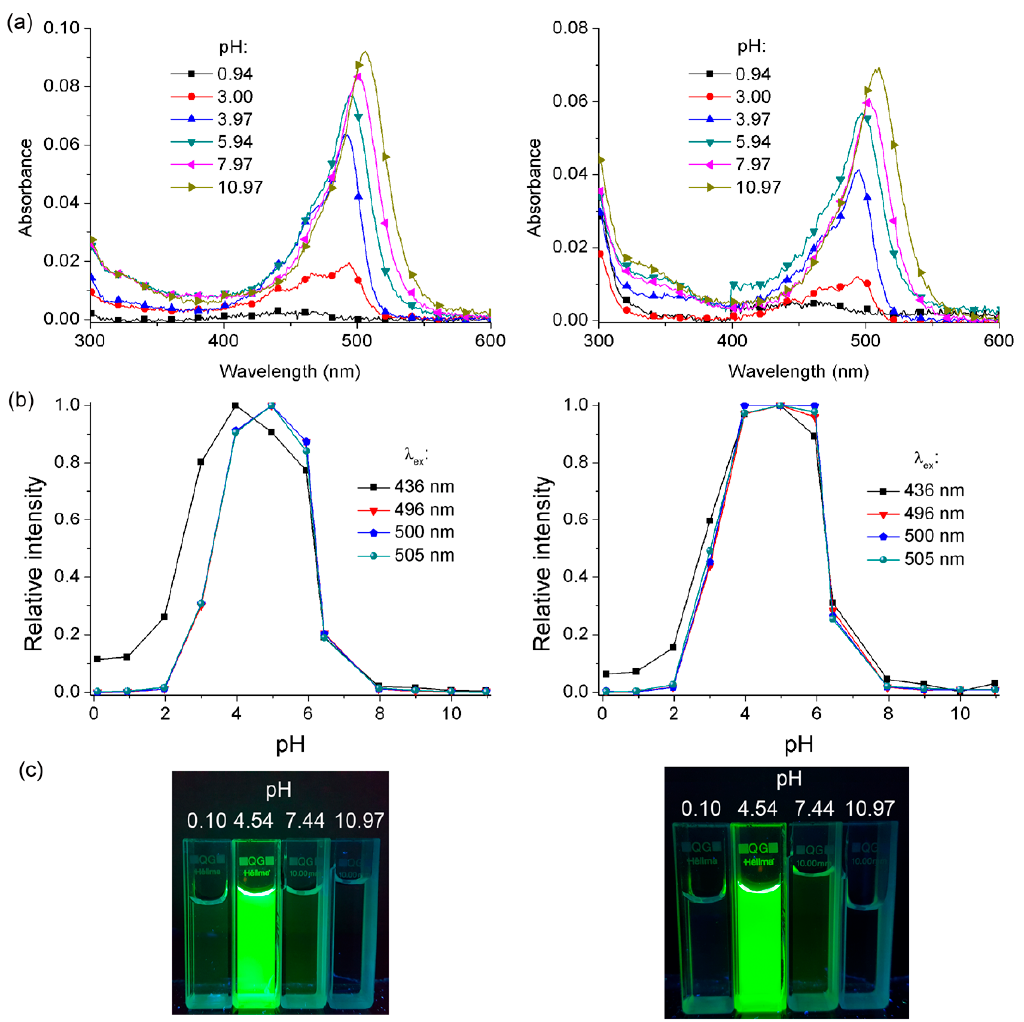
Figure 5. ( a ) Selected absorption spectra of 2 (2.5 μ M, left) and 3 (2.5 μ M, right) in 10 mM phosphate buffer at several pH levels at 25 °C. The spectra at pH 0.94 were obtained in HCl solution. All samples contain 0.05% DMSO to ensure solubility. ( b ) Relative intensity of maximum emission of 2 (512 nm, left) and 3 (514 nm, right), plotted with respect to pH; each protolytic species was excited at its maximum absorption wavelength. ( c ) Photographs of 2 (left) and 3 (right) solutions (concentration of each: 2.5 μ M) illuminated under a UV transilluminator (312 + 365 nm).